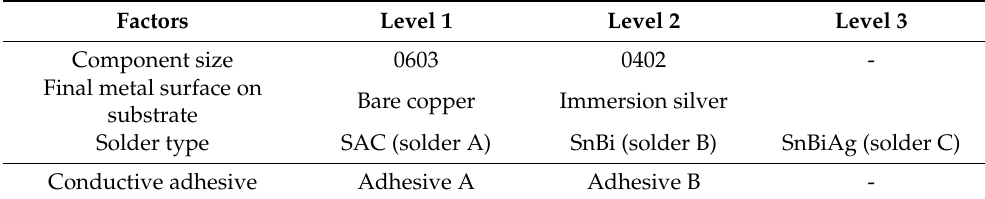
Figure 3. Circuit layout for dynamic bending test of foils with assembled 0402 and 0603 SMDs. Based on the results of the shear tests, the process parameters, adhesive reservoir depth 150 µ m, curing profile 150 ◦ C/12 min, and continuous furnace soldering, are selected for the bending tests. Table 2 shows the factors and levels used for DoE of dynamic bending tests. Table 2. Factors and levels for DoE of dynamic bending tests for soldering and conductive adhesive bonding. The factors and levels are evaluated in a full factorial manner, i.e., all factors are examined with all possible combinations.